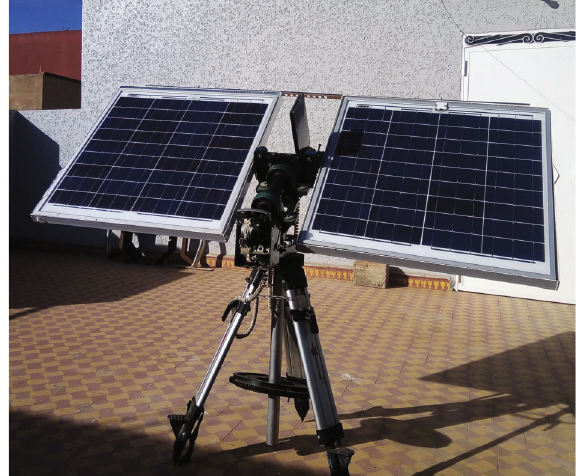
Figure 17: The realized model of solar